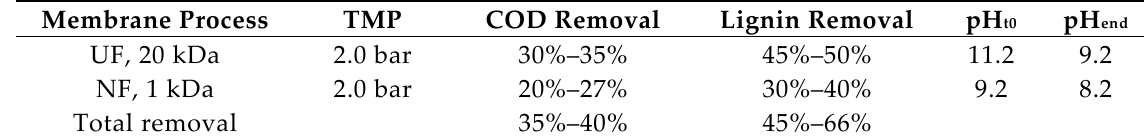
Table 7. Performance data for 20-kDa and 1-kDa ceramic membranes in series.